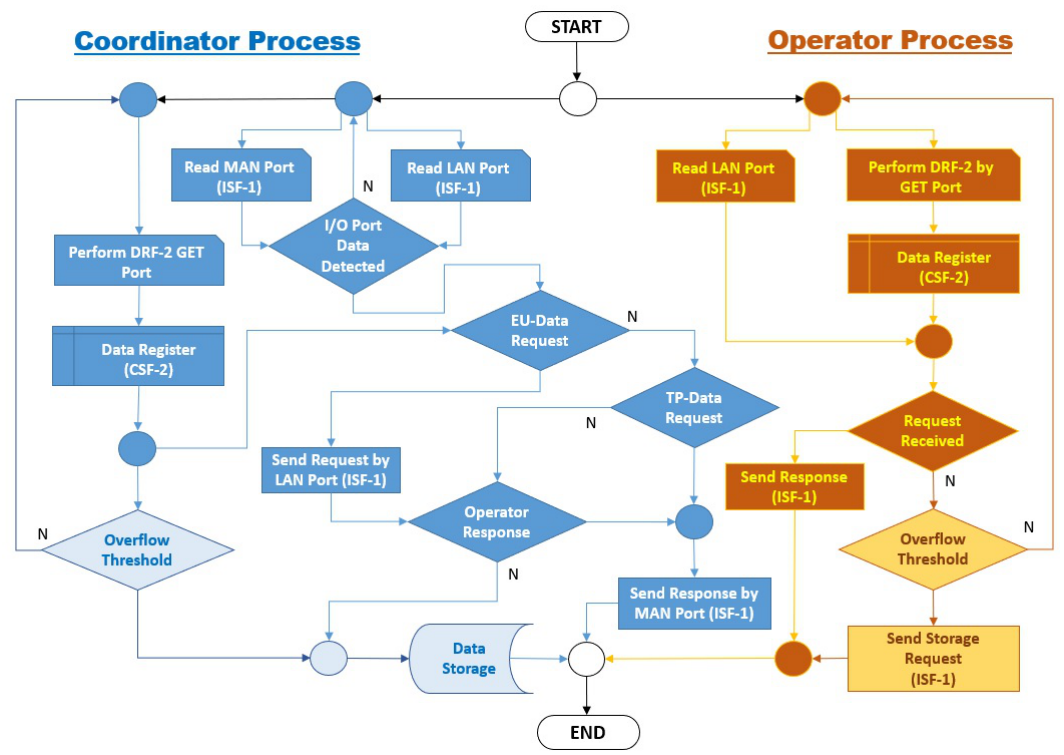
Figure 13. Flow diagram describing the test algorithm for the Telemetry